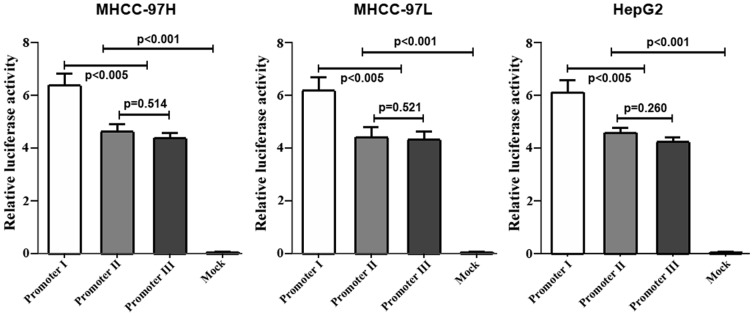
Comparison of luciferase activities in MHCC-97H, MHCC-97L and HepG2 cells transfected with promoter constructs I, II and III.MHCC-97H, MHCC-97L and HepG2 cells were transfected with promoter reporter constructs containing haplotype I (-1053AA/+64GG), promoter II (-1053AG/+64GC), and promoter III (-1053GG/+64 CC). The transcriptional activity in the three HCC cell lines transfected with haplotype I was much higher than that of promoter II, promoter III, and pGL3-Basic plasmid (mock control)(p<0.005, respectively). However, no difference was found between promoter II and promoter III.